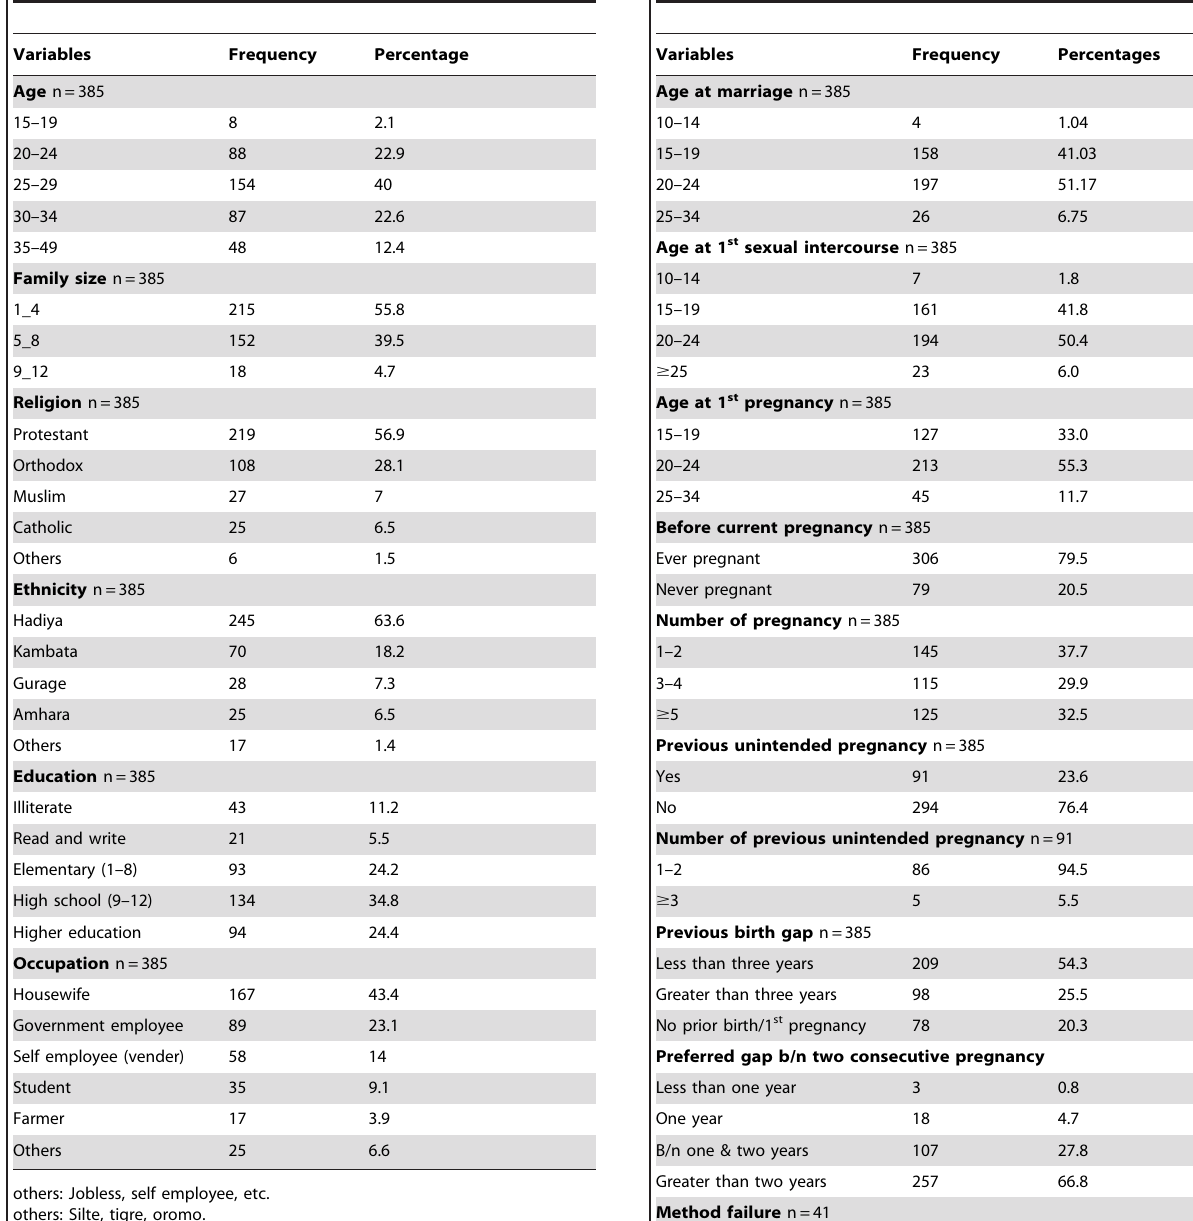
Table 1. Socio-Demographic Characteristics of Pregnant Married Women in Hossana Town, SNNP, April, 2011.